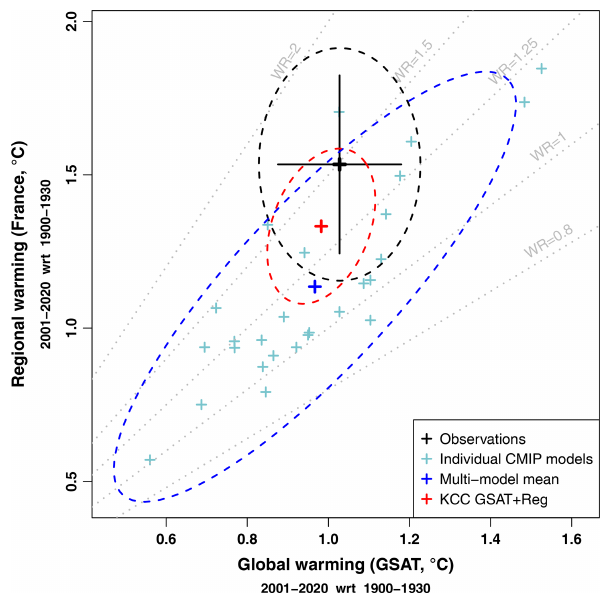
Figure 2. Global to regional warming over the period 2001–2020. Comparison of the global (GSAT) and regional (France) warmings over the period 2001–2020 with respect to 1900–1930. Black: ob- servations (cross), 5%–95% confidence ranges for the global and regional warmings separately (large cross), and 90% confidence 2- D region (dashed ellipse). Confidence ranges and region are based on assumed internal variability and observational uncertainty at global and regional levels. Light blue: estimated forced response for each CMIP6 model individually. Blue: CMIP6 multi-model mean (cross) and 90% confidence region (dashed ellipse) derived from the model spread. This confidence region corresponds to the prior used in the KCC constraint. Red: KCC-constrained estimate using both GSAT and regional observations to build the constraint. Gray: oblique dotted lines show a regional to global warming ratio (WR) of 0.8, 1, 1.25, 1.5, and